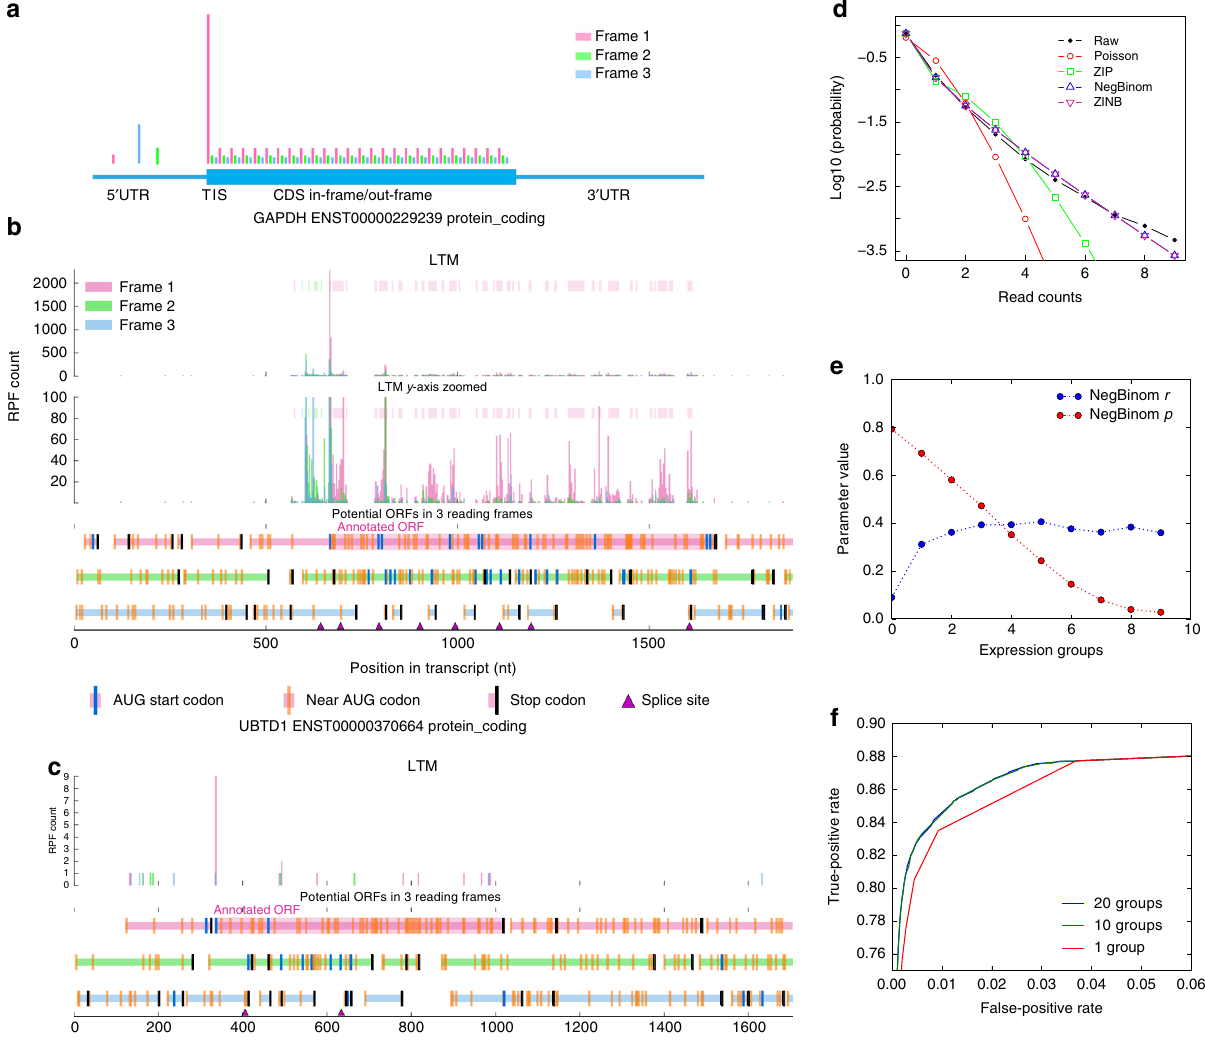
Fig. 3 Modeling background distribution of TI-seq data. a An illustration of the typical TI-seq RPF count pro fi le across a hypothetical protein-coding transcript. The RPF counts at the fi rst base of CDS in-frame codons (the pink bars inside ORF), excluding AUG or near-cognate start codons, from annotated PCGs, were used to model TI-seq data background. TI-seq RPF count pro fi le for the major isoform of b GAPDH and c UBTD1. d Fitting of different distributions including Poisson, zero-in fl ated Poisson (ZIP), negative bionomial (NB), and zero-in fl ated negative binomial (ZINB) to the observed background RPF count distribution. e NB distribution parameters ( r and p ) estimated from different TI-seq expression groups. f The use of different NB background distributions for transcripts/genes with different TI-seq signal density improved TIS identi fi cation compared to the use of a single/global